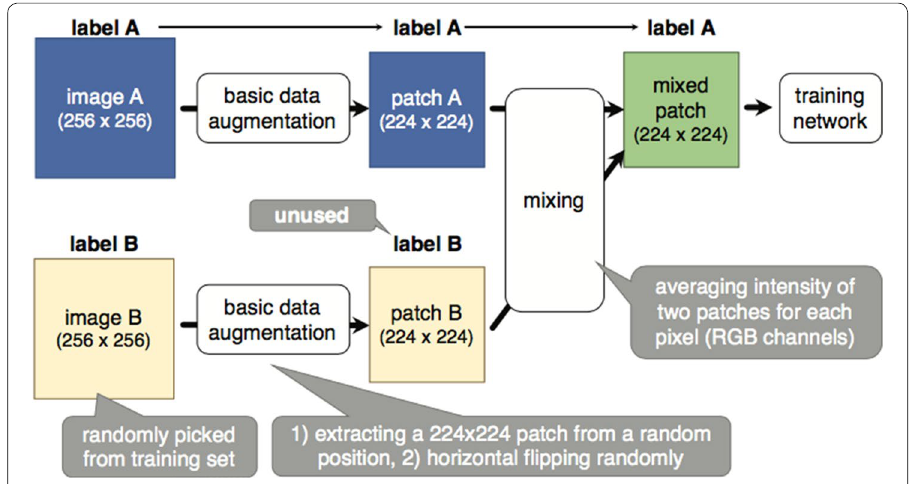
Fig. 7 SamplePairing augmentation strategy [65]